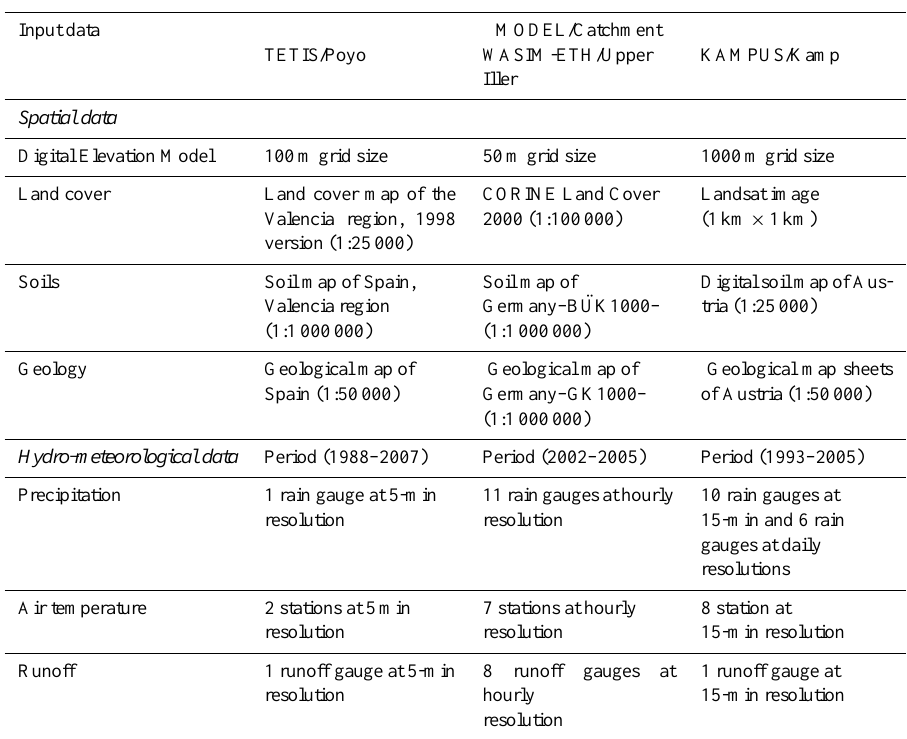
Table 2. Summary of available data for each catchment